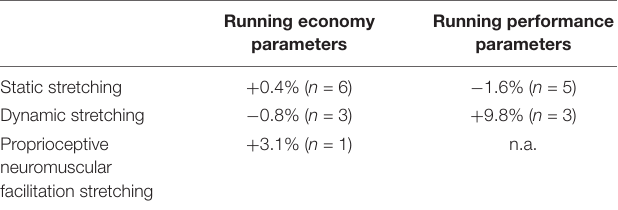
TABLE 3 | Average changes in running economy and running performance parameters as related to stretching technique. Running economy Running performance parameters